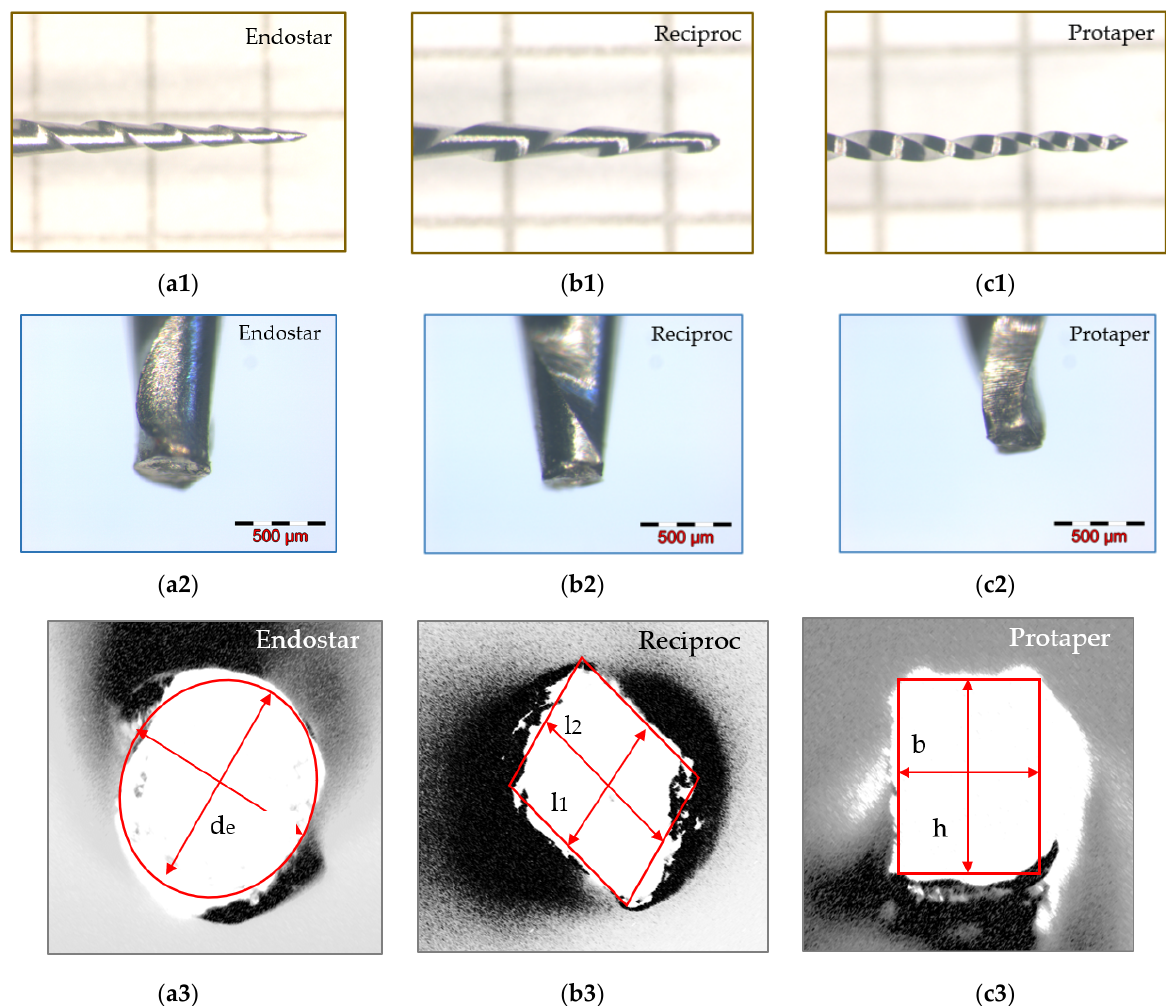
Figure 8. ( 1 ) Initial longitudinal profile, ( 2 ) lateral aspect of the fracture site, and ( 3 ) geometrical approximation of the fracture sections for an example of instruments from each study group: ( a ) Endostar, ( b ) Reciproc, and ( c ) Protaper. All images were obtained with optical microscopy with a 25× magnification.